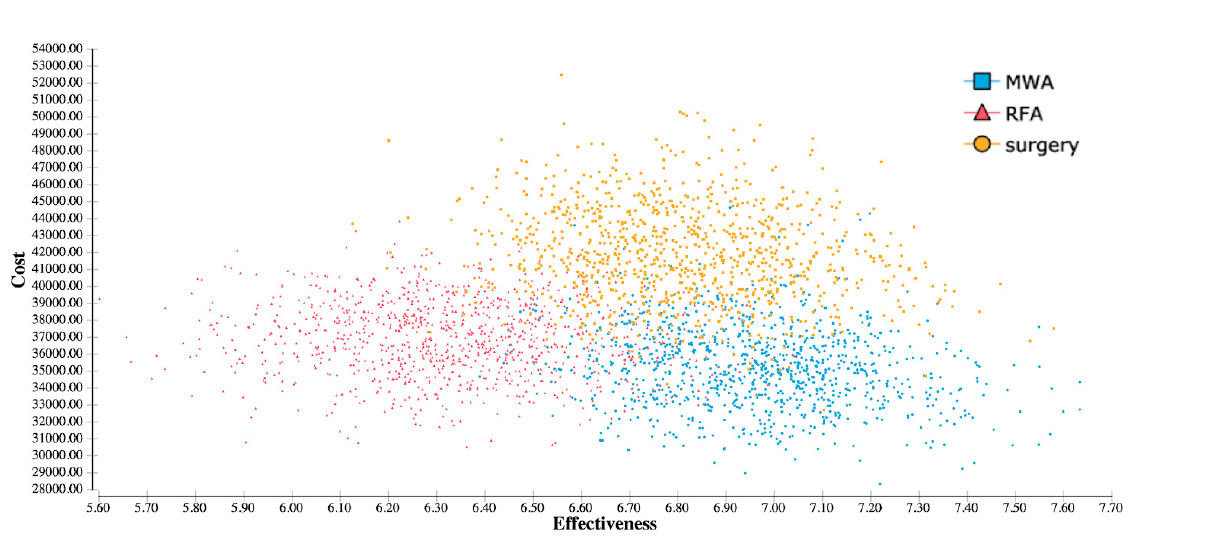
Figure 2. Cost-effectiveness scatterplot based on 30,000 iterations shows a higher effectiveness of MWA and surgery when compared to RFA. Additionally, MWA results in average lower costs than surgery.